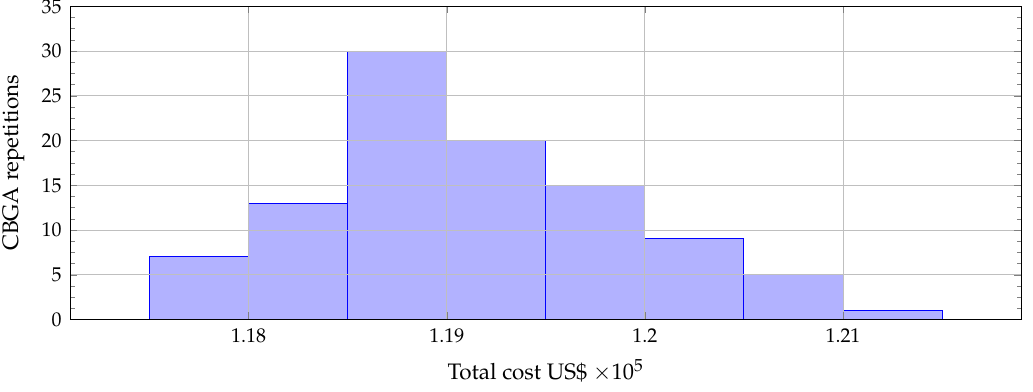
Figure 8. Behavior of the solutions in the 10-node test system after 100